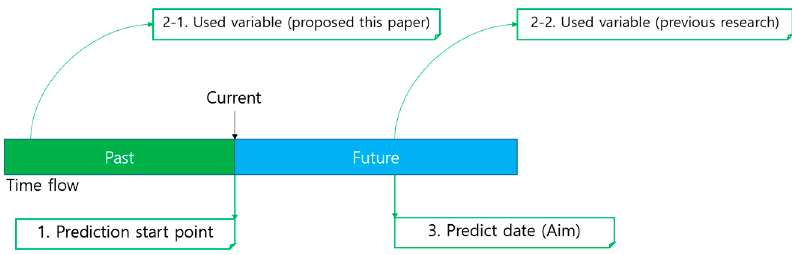
Figure 2. Time point of selected variable.